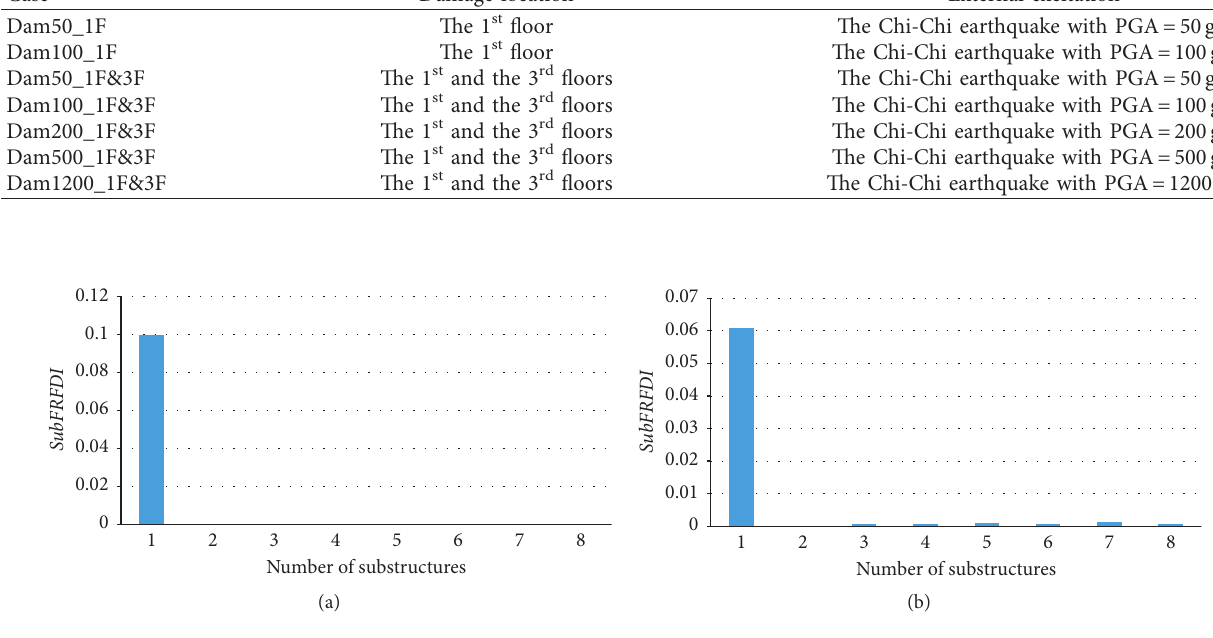
Figure 28: SubFRFDI values of LVDT-measured data for (a) case Dam50_1F and (b) case